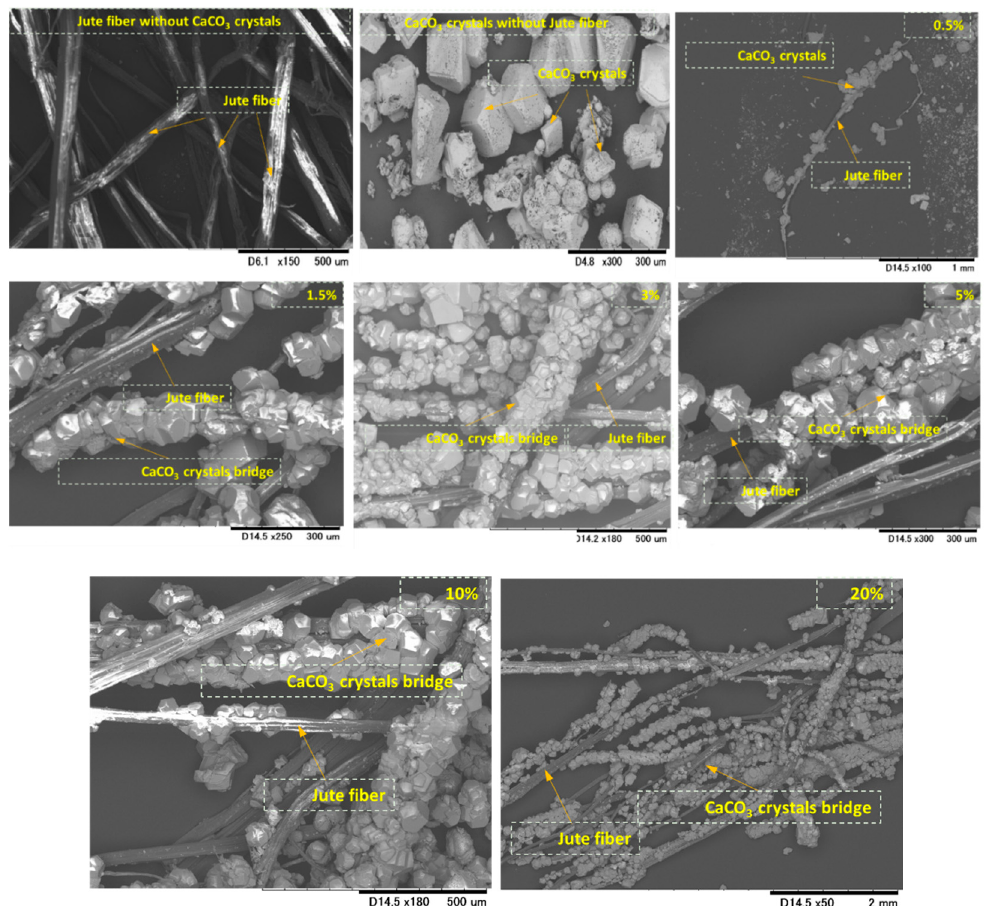
Figure 8. SEM images of precipitated CaCO 3 with and without jute fibers after the MICP process (without sand materials).